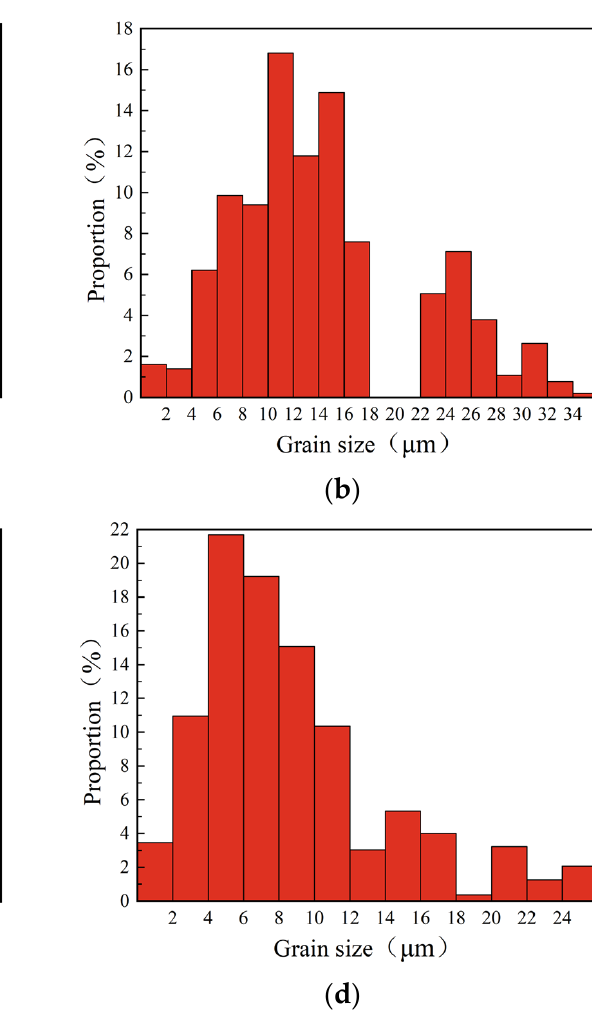
Figure 17. Grain size distribution in the metamorphic layer of GH4169 cutting surface under different flank wears: ( a ) VB = 0 mm; ( b ) VB = 0.1 mm; ( c ) VB = 0.2 mm; ( d ) VB = 0.3 mm.